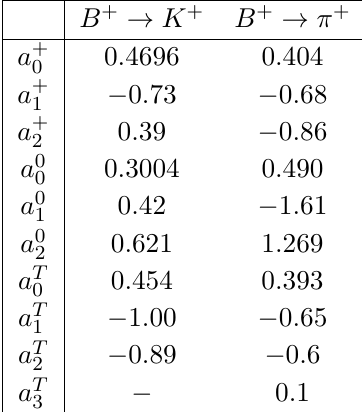
Table 27 . Fitting parameters of the form factors, f + , f 0 and f T , for the B + → K + and B + → π + modes